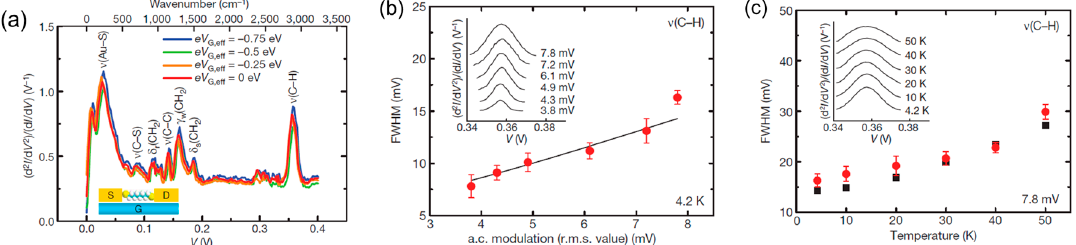
Figure 7. ( a ) IETS spectrum for the octanedithiol single-molecule junction. ( b , c ) Full width at half-maximum (FWHM) of the C–H stretching mode peak as a function of alternating-current (AC) modulation voltage and temperature. Experimental data are indicated by circles, and theoretical values are indicated by the solid line ( b ) and squares ( c ). Insets: examples of IETS spectra for different AC modulation voltage ( b ) and temperature ( c ). Reproduced with permission from [14,38] copyright Nano Letter Publishing Group 2008 and Nature Material Publishing Group 2006.